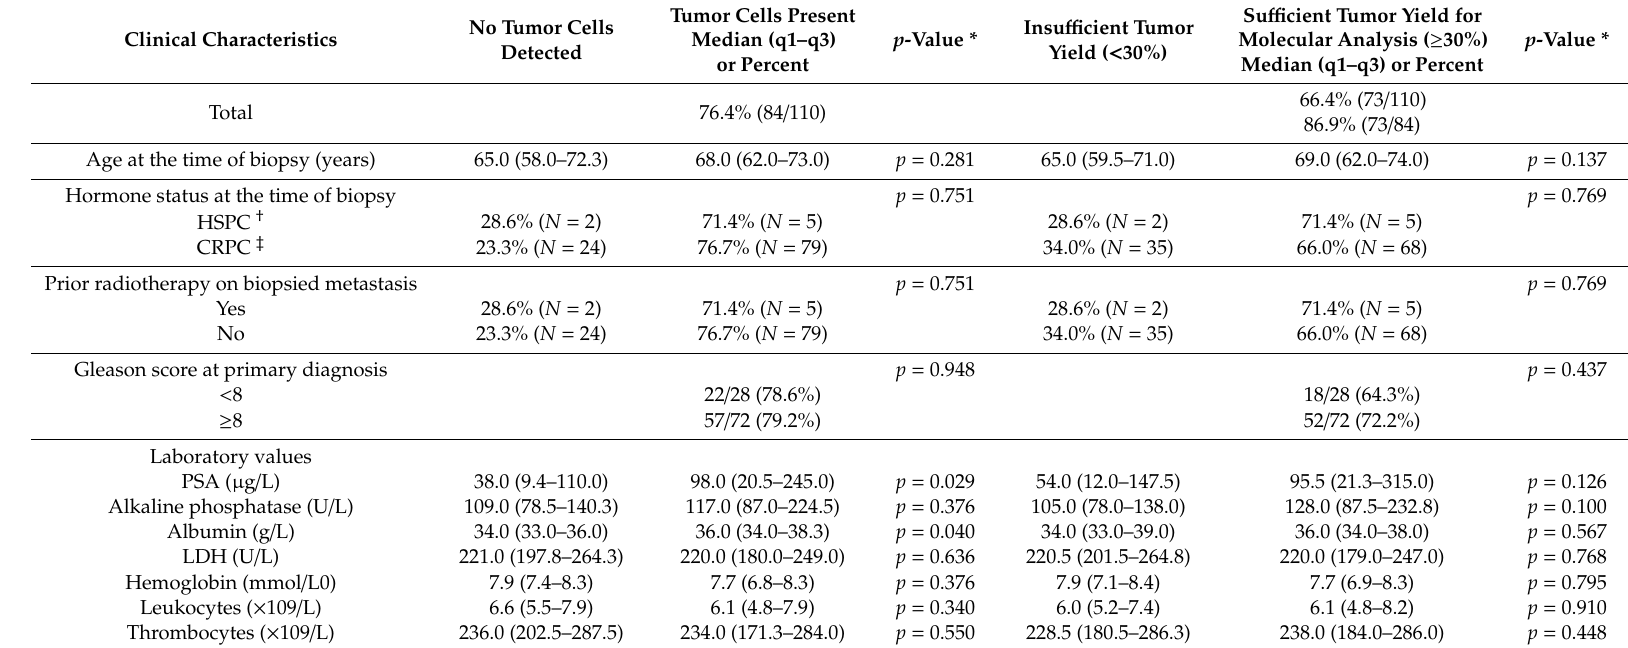
Table 1. Clinical characteristics and denominators of total